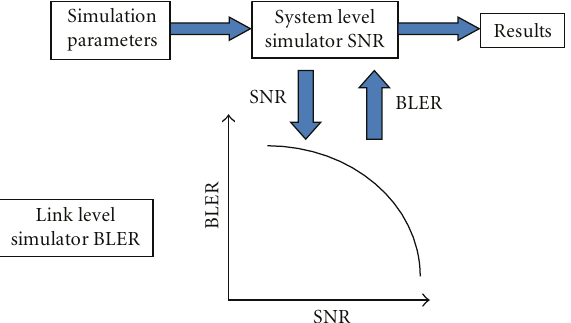
Figure 2: Interaction between link level simulator and system level